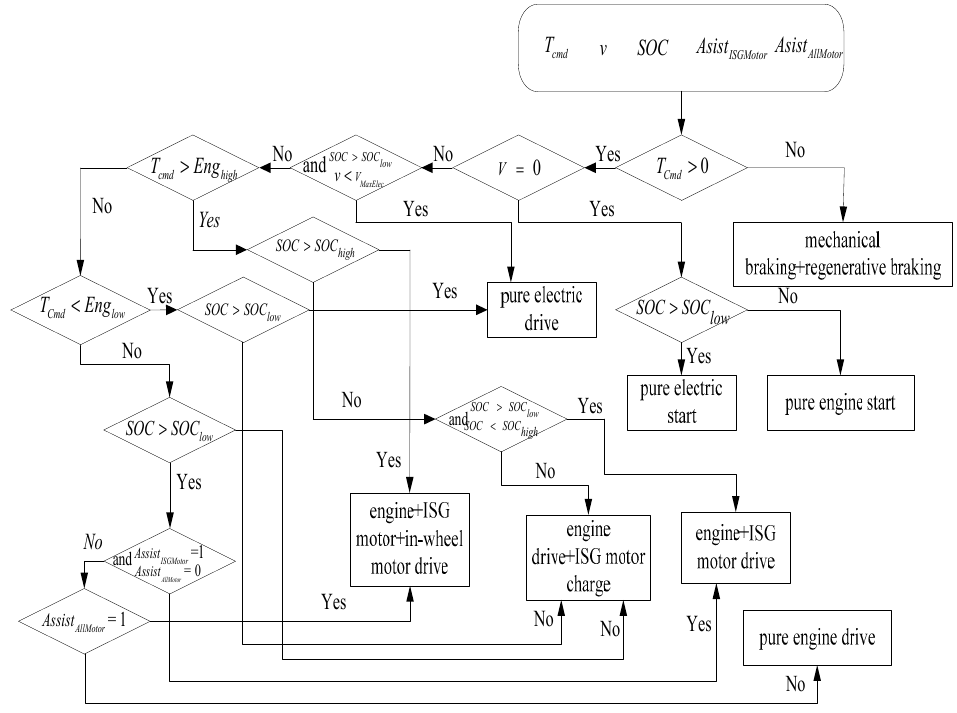
Figure 12. Control logic flow for various driving modes.